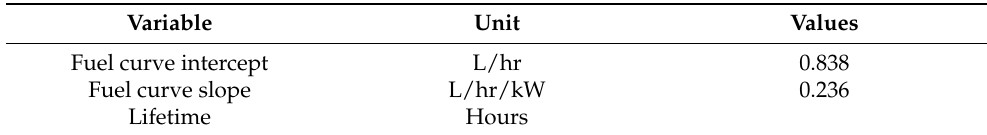
Table 6. Specifications of the diesel